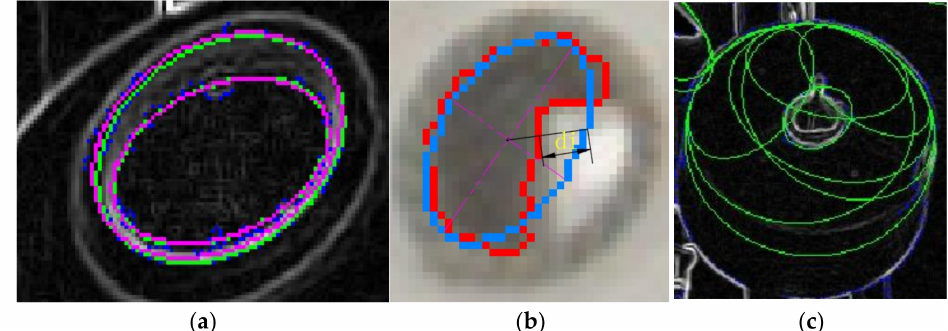
Figure 7. ( a ) Fit points into ellipse. ( b ) di is fitting error. ( c ) Fitting ellipse with some points in a set. The next step is to segment and merge the points